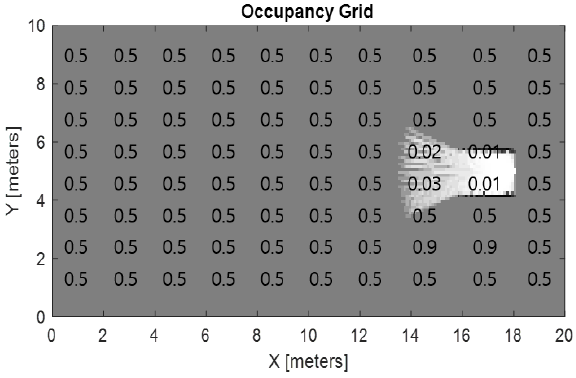
Figure 4. The occupancy map visualization with occupancy probability values of uncertainties (0.5) and explored values (varying from 0.0010 to 0.5). The map size is defined as 20 by 10. It is only for representing the figure window of the simulation and is not used in the algorithm computation.